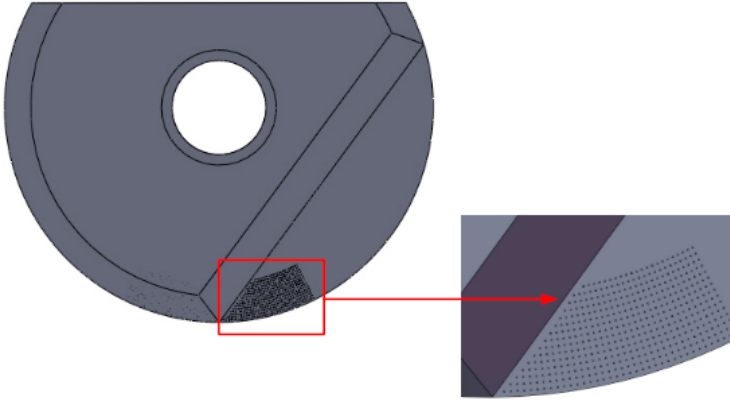
Table 2. Four factors and five levels table of the simulation parameters.